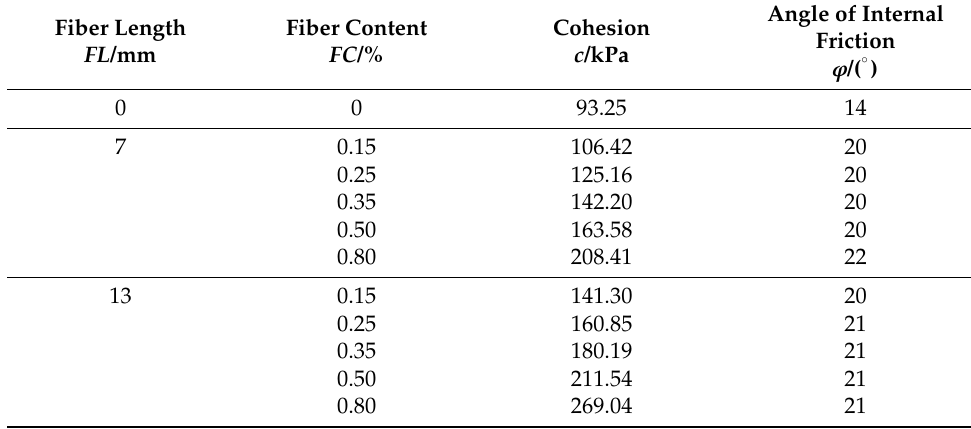
Figure 2. Effect of fiber content on stress-strain ( σ 3 = 200 kPa). Table 4. Shear strength of fiber-reinforced red